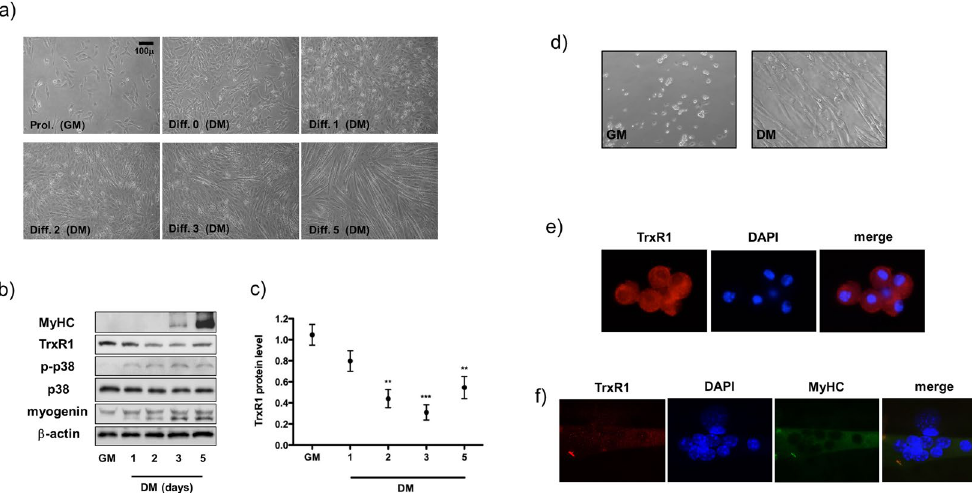
Figure 1. TrxR1 is downregulated during skeletal muscle differentiation. ( a ) Representative image of C2C12 myoblasts differentiation process. Growth medium (GM) is maintained in proliferation conditions (Prol) until 90% confluency. Pictures were taken respectively at 0, 1, 2, 3 and 5 days after switching to differentiation media (DM). ( b ) Western blot analysis showing the TrxR1 protein contents in C2C12 cells cultivated in GM and DM (1, 2, 3, 5 days) conditions. Antibodies against Myogenin, p38, p-p38 and MyHC were used to monitor myogenesis process, whereas β -actin was employed as a housekeeping loading control. ( c ) Relative quantification of TrxR1 protein expression normalized to β -actin levels of western blots in figure b. The TrxR1/ β -actin ratio in GM conditions is set = 1. Results are represented as mean ± SEM of three independent experiments. ( d ) Images (10x magnification) of murine satellite cells in proliferation (GM) and 5 days after switching to differentiation media (DM). ( e ) Representative image (63x magnification) of the immunofluorescence analysis showing TrxR1 expression in satellite cells and in ( f ) myotubes originated from them. Multinucleated myotubes are positive for MyHC and DAPI staining was used to detect